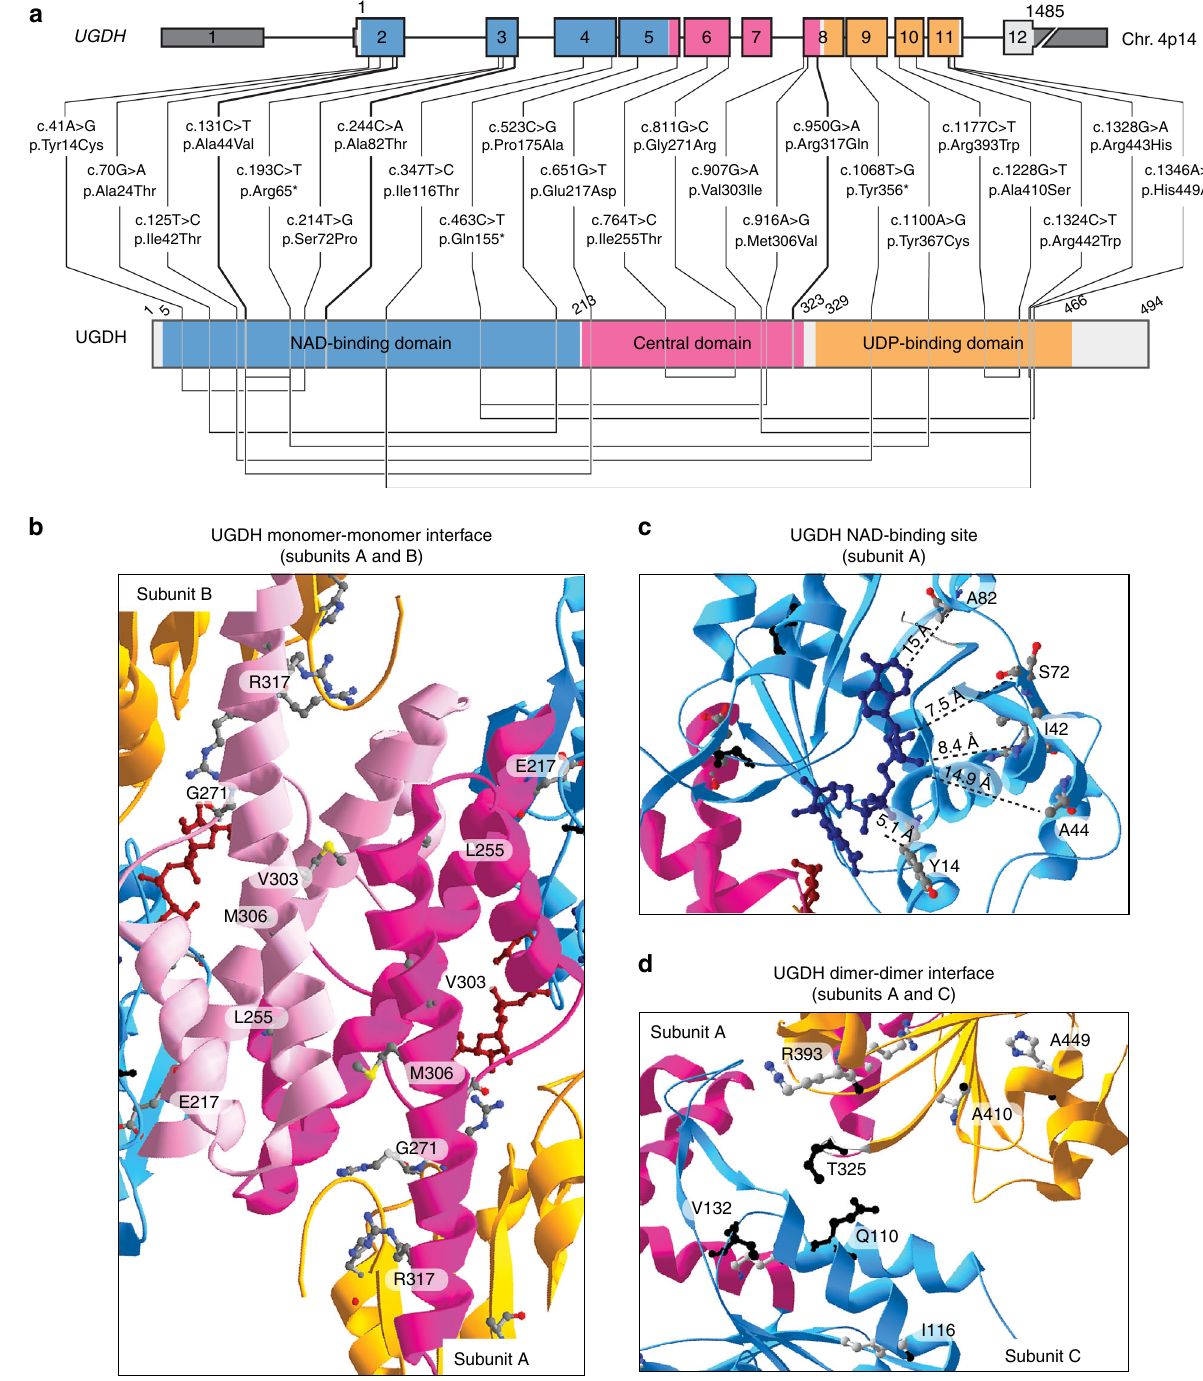
Fig. 2 Mutations in UGDH enzyme possibly affect critical amino-acids. a UGDH genomic and protein domain structures. Type and positions of 22 germline UGDH mutations. 5 ′ and 3 ′ UTRs are shown in dark gray. NAD-binding (blue), central (pink), and UDP-binding (orange) domains are highlighted. Homozygous mutations are shown in bold. Compound heterozygous mutations that are in trans are linked by a line below the UGDH domain structure. b – d Three close-up views ribbon diagrams of the UGDH protein bound to UDP-Glc and NADH. b Interface between the central domains of subunits A and B. c NAD-binding site in NAD-binding domain of subunit A. Distances between NADH and mutated residues in patients are measured in Angström (Å). d Interface between the subunit A NAD-binding domain with the subunit C UDP-Glc-binding domain. In all the structures, residues carrying missense mutations in the patients are highlighted as 3D backbone. Residues Q110 and T325 known to interact together for dimer formation 15 ; and residue V132, which is important for hexamerization 15 are highlighted in black backbone. In all the structures, NAD-binding (blue), central (light/dark pink), and UDP- binding (orange) domains are shown. UDP-Glc (dark red) and NADH (midnight blue) are represented as colored carbon backbones. Adapted from PDB code 2Q3E 6 using the Swiss-Pdb Viewer software 67 . For gels and graphs source data, please refer to the source data fi les 1 and